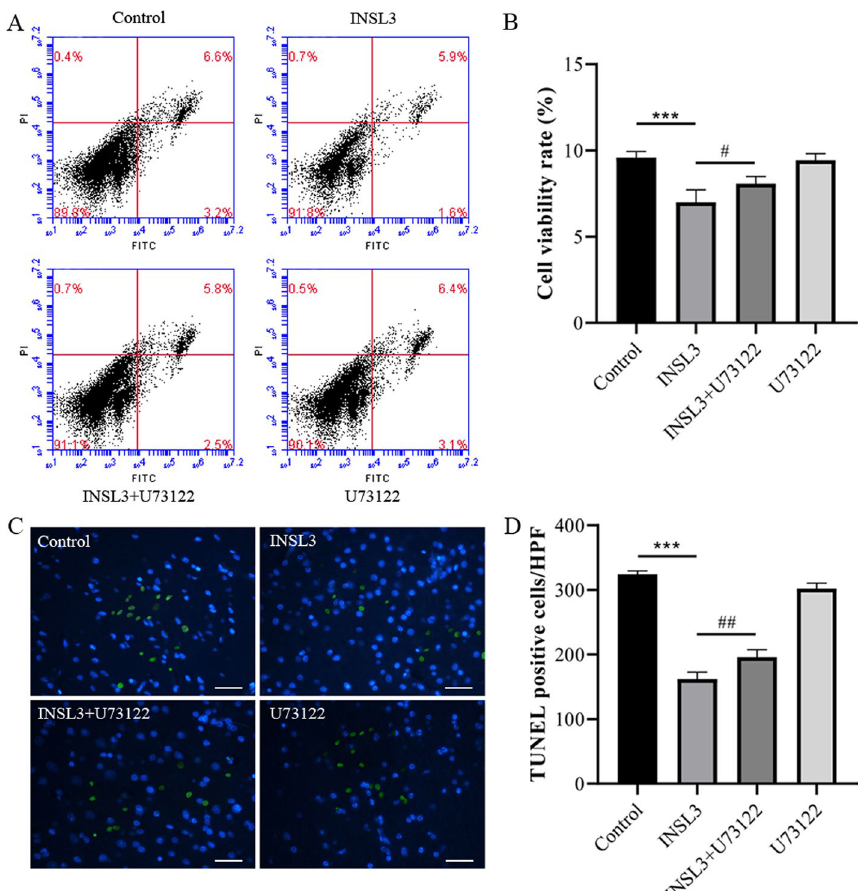
Fig. 3 U73122 inhibited the anti-apoptotic effect of INSL3 on gubernacular cells. A, B Flow cytometry evaluate the effect of INSL3 on apoptosis of gubernacular cells. C, D Cell apoptosis was detected by TUNEL staining. Scale bars, 50 μm Data are mean standard deviation of three independent experiments. ± * &# P < 0.05, ** &## P < 0.01, and *** &### P <